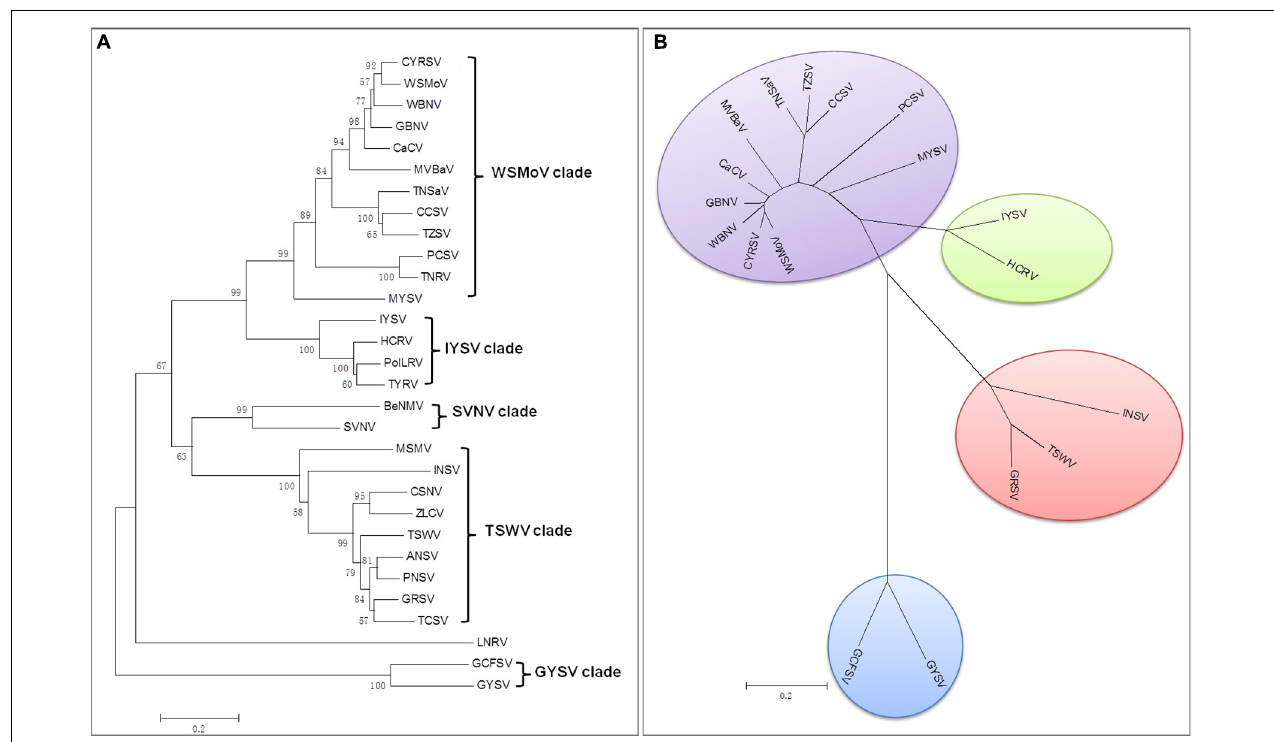
FIGURE 2 | Phylogenetic tree of orthotospoviruses based on the amino acid sequence of nucleocapsid (N) protein. (A) Phylogenetic tree of 30 orthotospoviruses reported worldwide. (B) Phylogenetic tree of the 17 orthotospoviruses reported from China. Bootstrap values on the branches represent support for the branches based on 1,000 bootstrap replicates. Definitive species are written in italics and tentative species are written in upright letters. Abbreviations (and NCBI no.): ANSV, Alstroemeria necrotic spot orthotospovirus (GQ478668); BeNMV, Bean necrotic mosaic orthotospovirus (NC_018071); CaCV, Capsicum chlorosis orthotospovirus (NC_008301); CCSV, Calla lily chlorotic spot orthotospovirus (AY867502); CSNV, Chrysanthemum stem necrosis orthotospovirus (NC_027719); CYRSV, Chili yellow ringspot orthotospovirus (MH779495); GBNV, Groundnut bud necrosis orthotospovirus (NC_003619); GRSV, Groundnut ringspot orthotospovirus ; GYSV, Groundnut yellow spot orthotospovirus (AF013994); HCRV, Hippeastrum chlorotic ringspot orthotospovirus (KC290943); INSV, Impatiens necrotic spot orthotospovirus (NC_003624); IYSV, Iris yellow spot orthotospovirus (AF001387); LNRV, Lisianthus necrotic ringspot orthotospovirus (AB852525); MSMV, Melon severe mosaic orthotospovirus (EU275149); MVBaV, Mulberry vein banding associated orthotospovirus (KM819701); MYSV, Melon yellow spot orthotospovirus (AB038343); GCFSV, Groundnut chlorotic fan-spot orthotospovirus (AF080526); PCSV, Pepper chlorotic spot orthotospovirus (KF383956); PolRSV, Polygonum ringspot orthotospovirus (KF383956); PNSV, Pepper necrotic spot orthotospovirus (HE584762); SVNV, Soybean vein necrosis-associated orthotospovirus (HQ728387); TCSV, Tomato chlorotic spot orthotospovirus (S54325); TSWV, Tomato spotted wilt orthotospovirus (NC_002051); TNRV, Tomato necrotic ringspot orthotospovirus (FJ489600); TNSaV, Tomato necrotic spot-associated orthotospovirus (KM355773); TYRV, Tomato yellow ring orthotospovirus (AY686718); TZSV, Tomato zonate spot orthotospovirus (NC_010489); WBNV, Watermelon bud necrosis orthotospovirus (EU249351); WSMoV, Watermelon silver mottle orthotospovirus